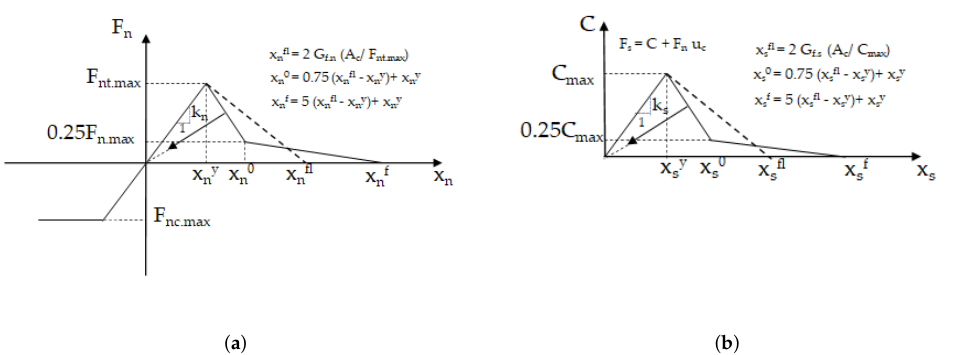
Figure 1. Bilinear softening contact model under tensile loading and shear and the yielding contact model under compressive loading. ( a ) Normal direction; ( b ) Shear direction.